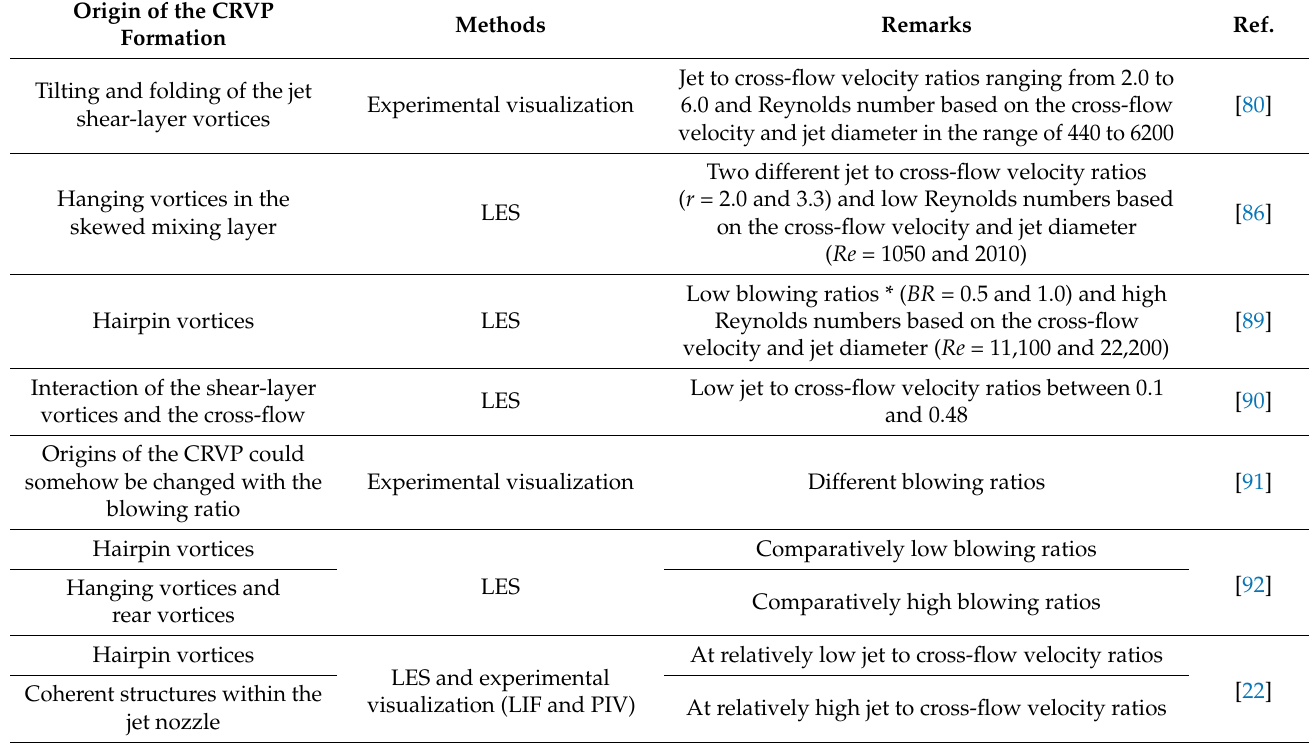
Table 3. Highlighted research efforts regarding CRVP formation